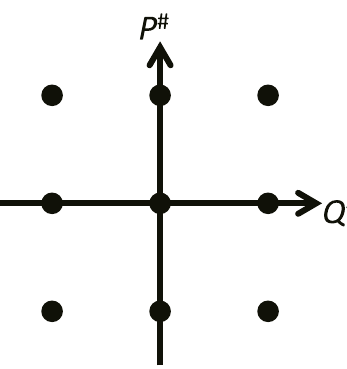
Figure 1 . The Newton polygon of the D 5 del Pezzo curve.